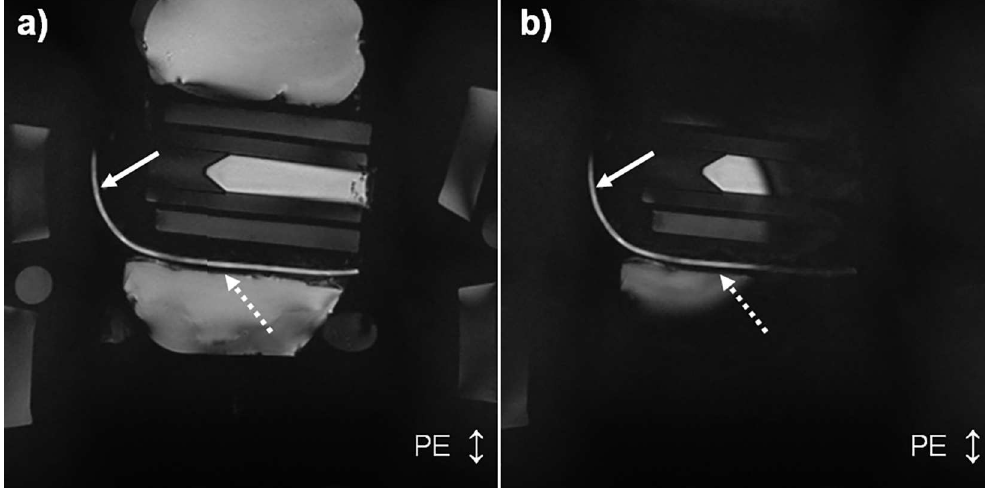
Fig 4. Sample scan (R = 1) of the phantom used for vessel sharpness measurements, imaged using a) the conventional adiabatic T 2 -Prep and b) the 2D-T 2 -Prep. Images were acquiredwith acceleration factors of R = 1,2,3,4,5, and 6, where the phase encoded (accelerated) direction is indicatedby the two-headedarrow at the bottom right. Vessel sharpnesswas measured along the artificial vessel, in portions parallelto the accelerated direction (solid arrow) and perpendicular to the accelerateddirection (dashed arrow).